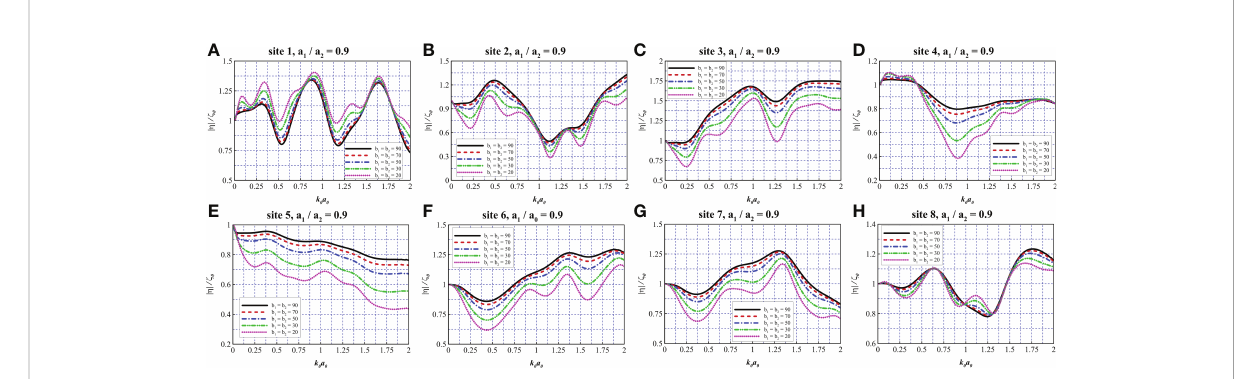
FIGURE 10 Comparison of wave elevation at different measurement sites with various porosity parameters. (A – H) a1/a2 = 0.9, site